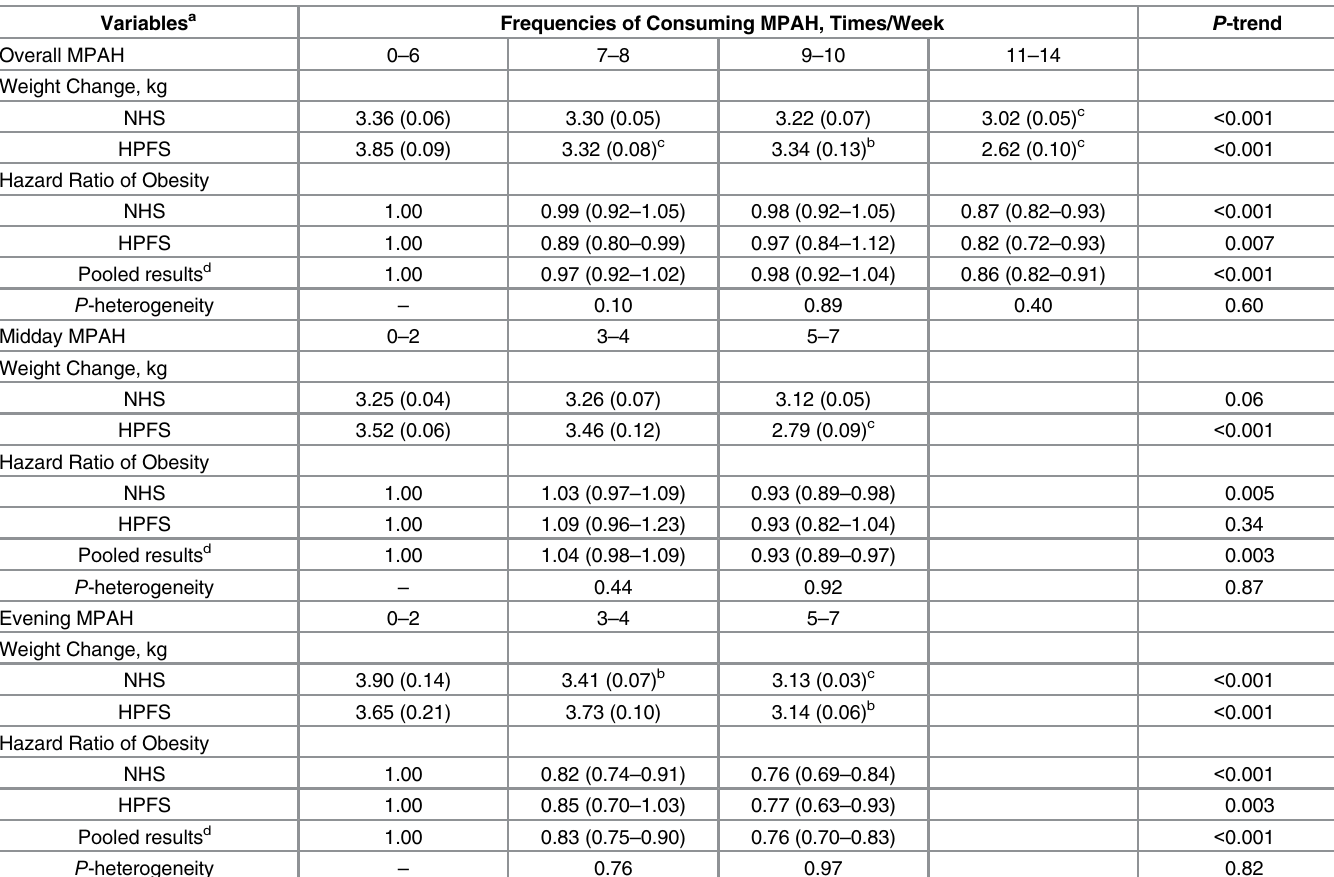
Table 3. Weight changes and risk of obesity according to frequencies of meals prepared at home, based on the NHS and the HPFS (1986 – 1994). Variables